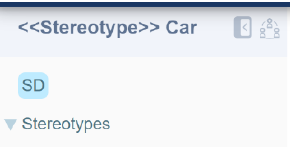
Figure 5. A Stereotype model name example.